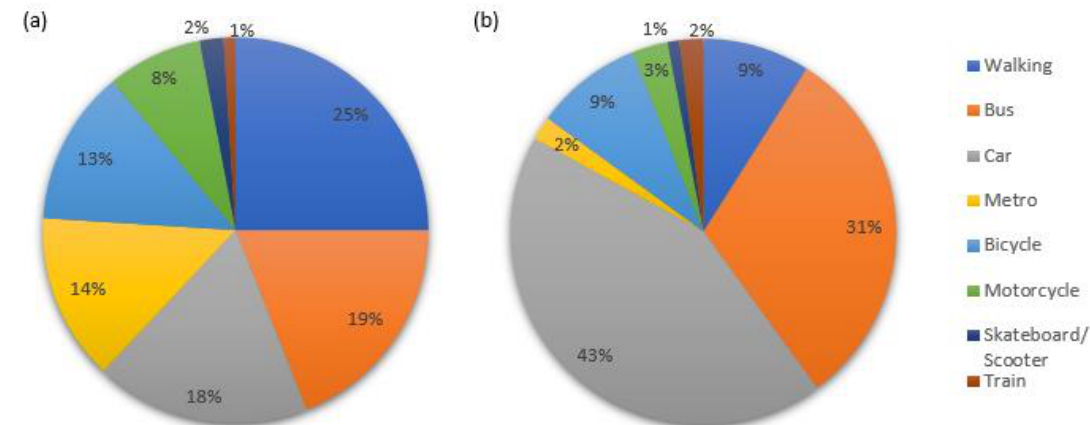
Figure 3. Means of transportation most frequently used by students of ( a ) Higher Polytechnic School (HPS) and ( b ) Higher Technical School of Engineering (HTSE).